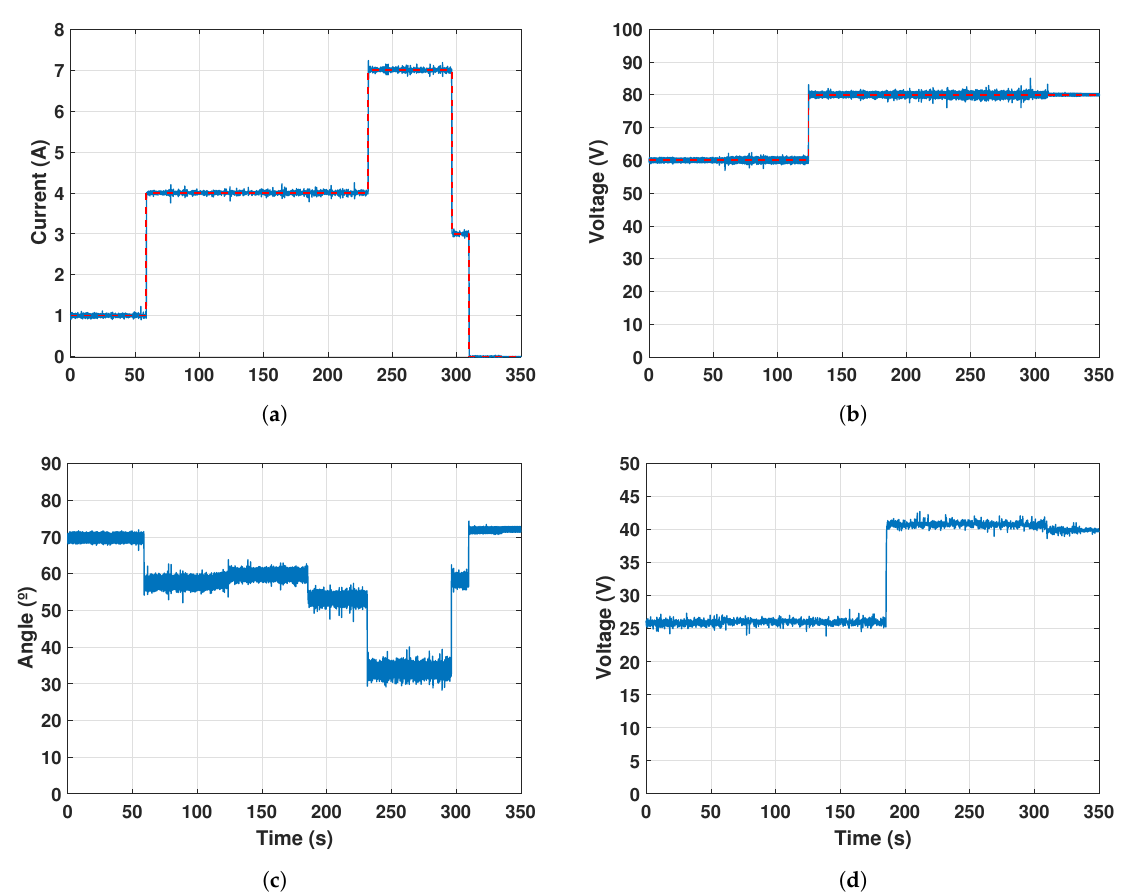
Figure 18. Experimental results. Time responses of: ( a ) the battery current i b (blue) and the reference i ∗ (red); ( b ) the voltage v DC 2 (blue) and the reference v ∗ carried out by the regulator R DC 2 c ( s ) ; ( d ) the voltage of the battery v b